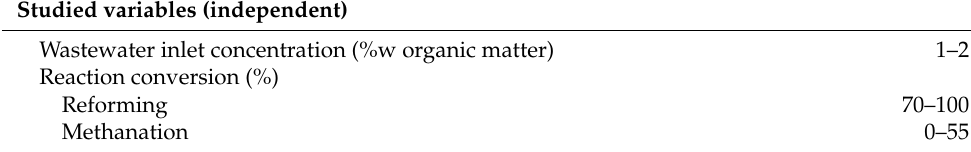
Table 2. Operating conditions and studied variables for process heat balance analysis.